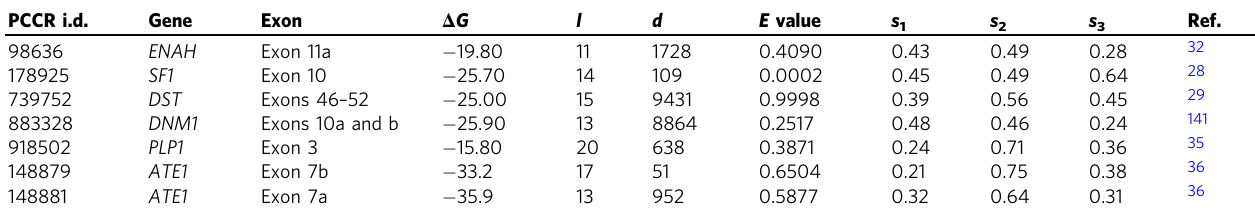
Table 1 Experimentally validated (bona fi de) RNA structures in human genes that satis fi ed PrePH search criteria. PCCR